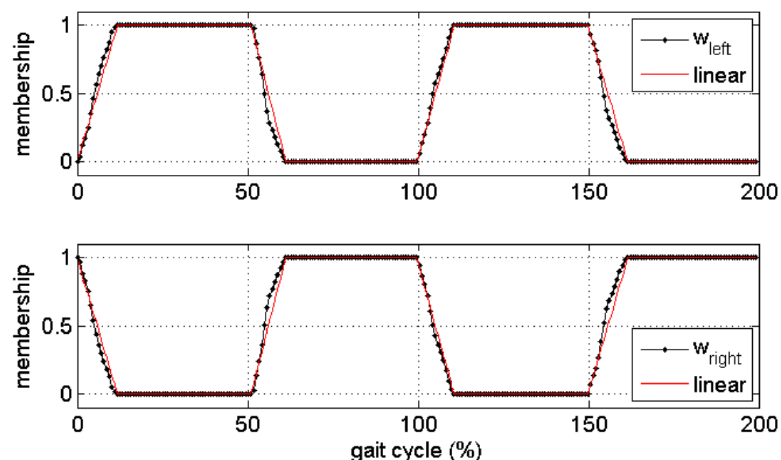
Figure 19. Membership function for the distribution of vertical GRF among the two feet as determined by [87]. The upper line is the left membership function, representing the left single support phases. The bottom line represents the right membership function. The transients represent the double support.